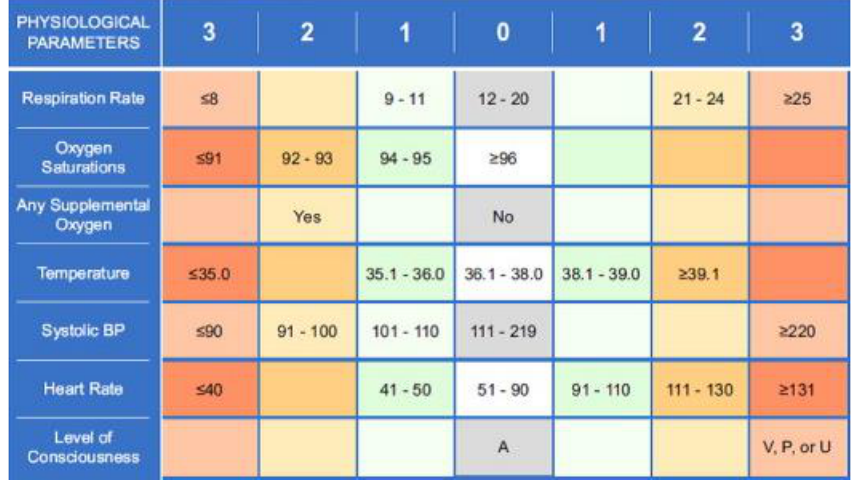
Figure A1. National Early Warning Score (Royal College of Physicians, 2012).